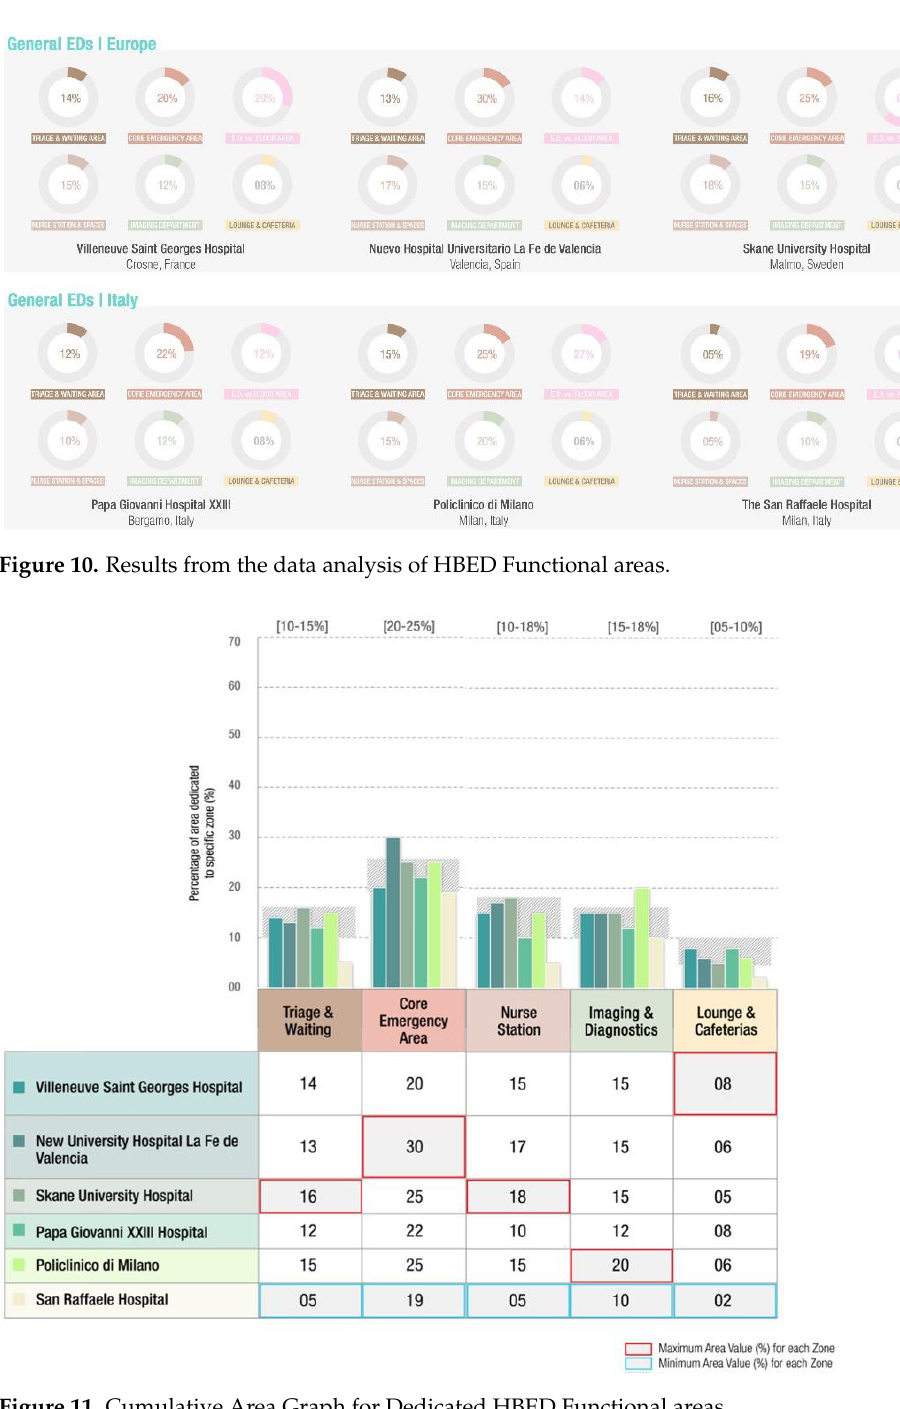
Figure 11. Cumulative Area Graph for Dedicated HBED Functional areas.